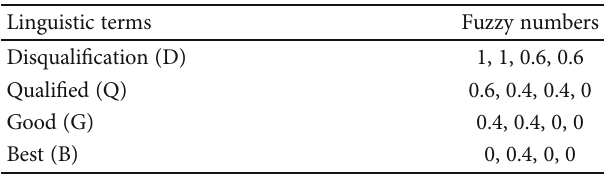
Table 2: Linguistic terms and corresponding fuzzy numbers.